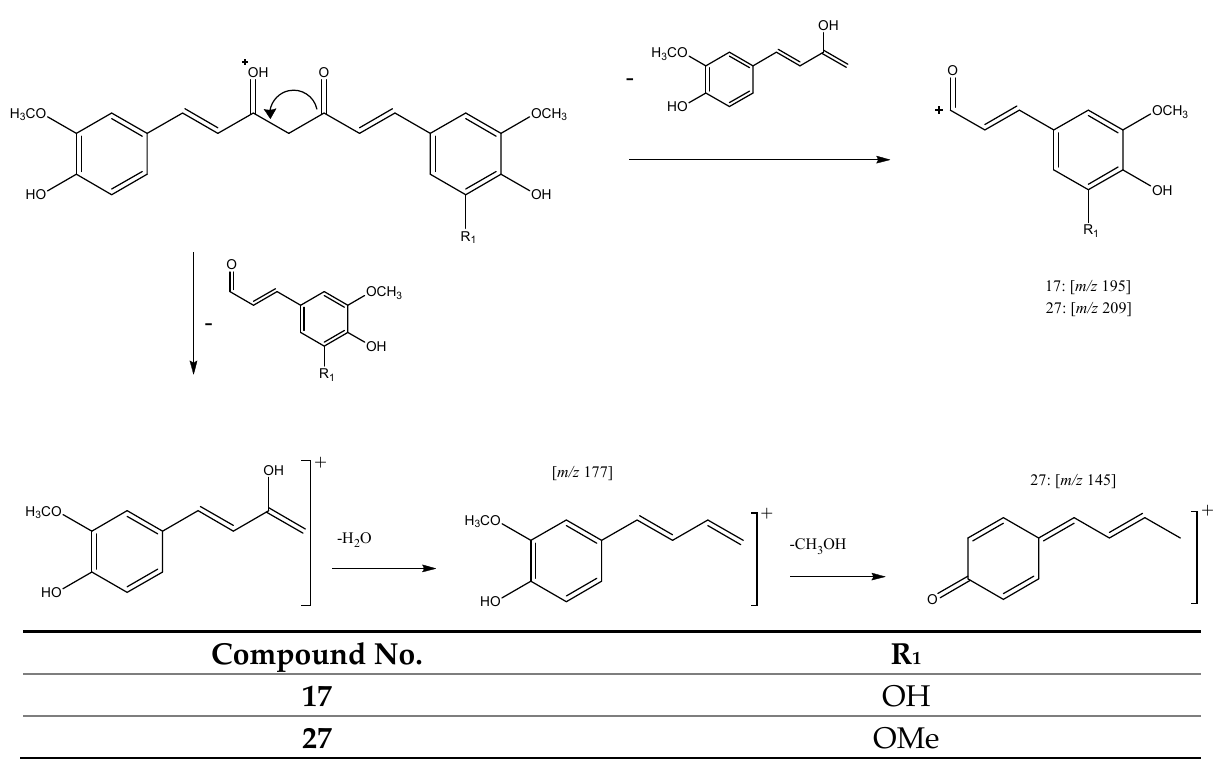
Figure 5. Fragmentation pathway of compounds 17 and 27 .